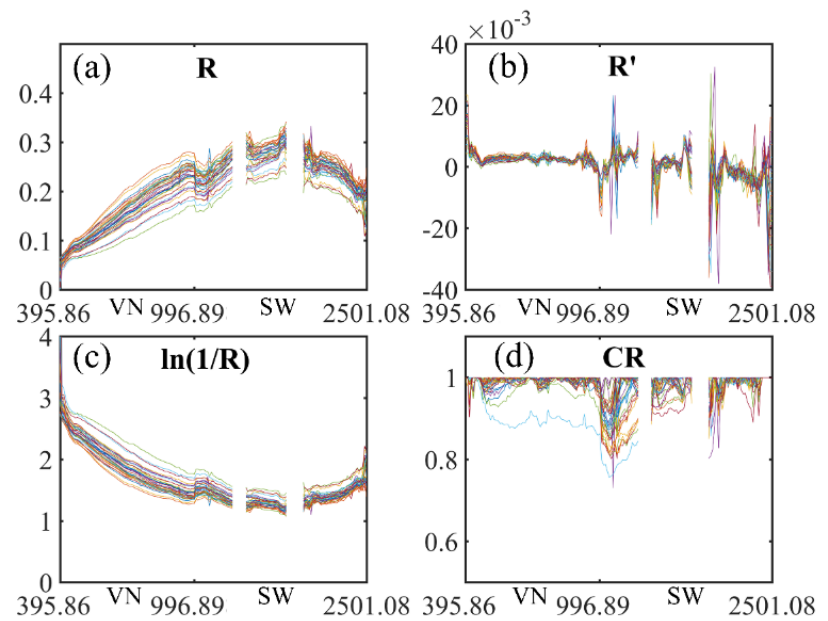
Figure 6. ( a ) ZY1-02D spectral reflectance; ( b ) The first derivative of the ZY1-02D reflectance; ( c ) The logarithm of the reciprocal to the ZY1-02D reflectance; ( d ) The result of the continuum removal to the ZY1-02D reflectance. Axis X indicates the spectral region (unit: nm).